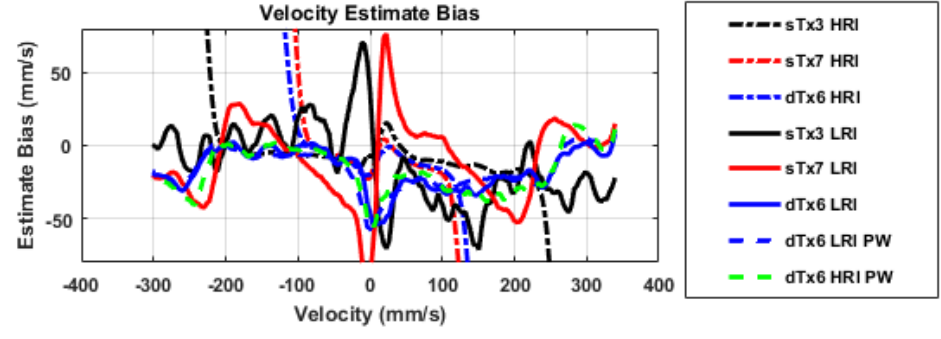
Figure A3. All estimators exhibit a slight negatively sloping trend, suggesting a possible alignment error in the ground truth. The HRI estimators each show evidence of aliasing at the predicted Nyquist